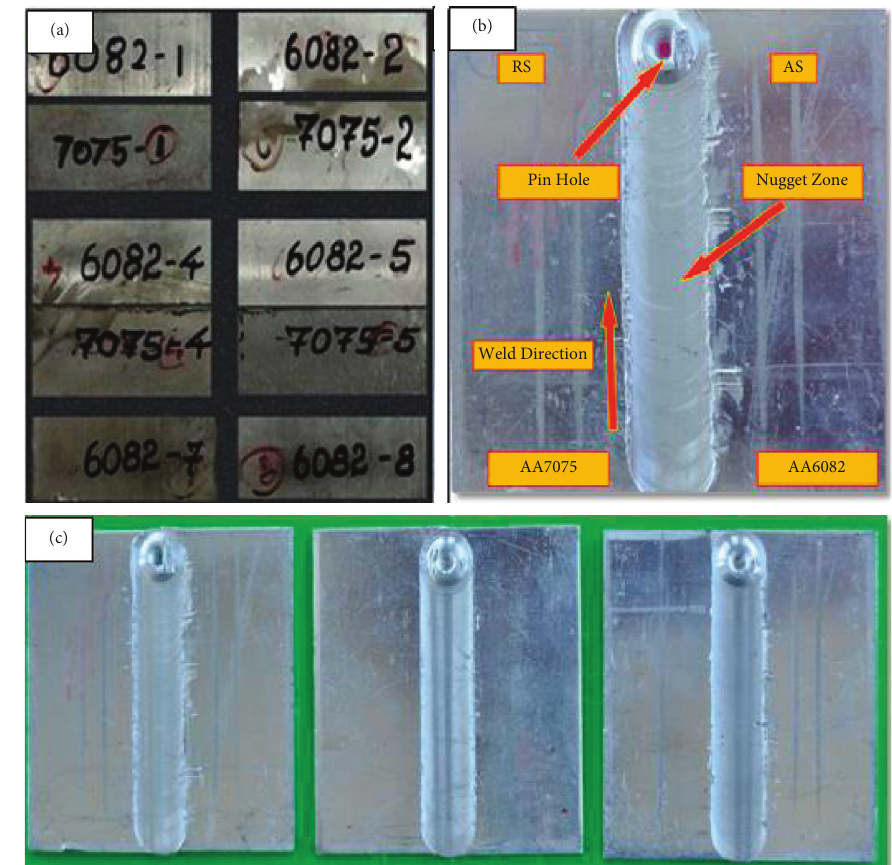
Figure 3: A photographic view of the joints before and after welding.